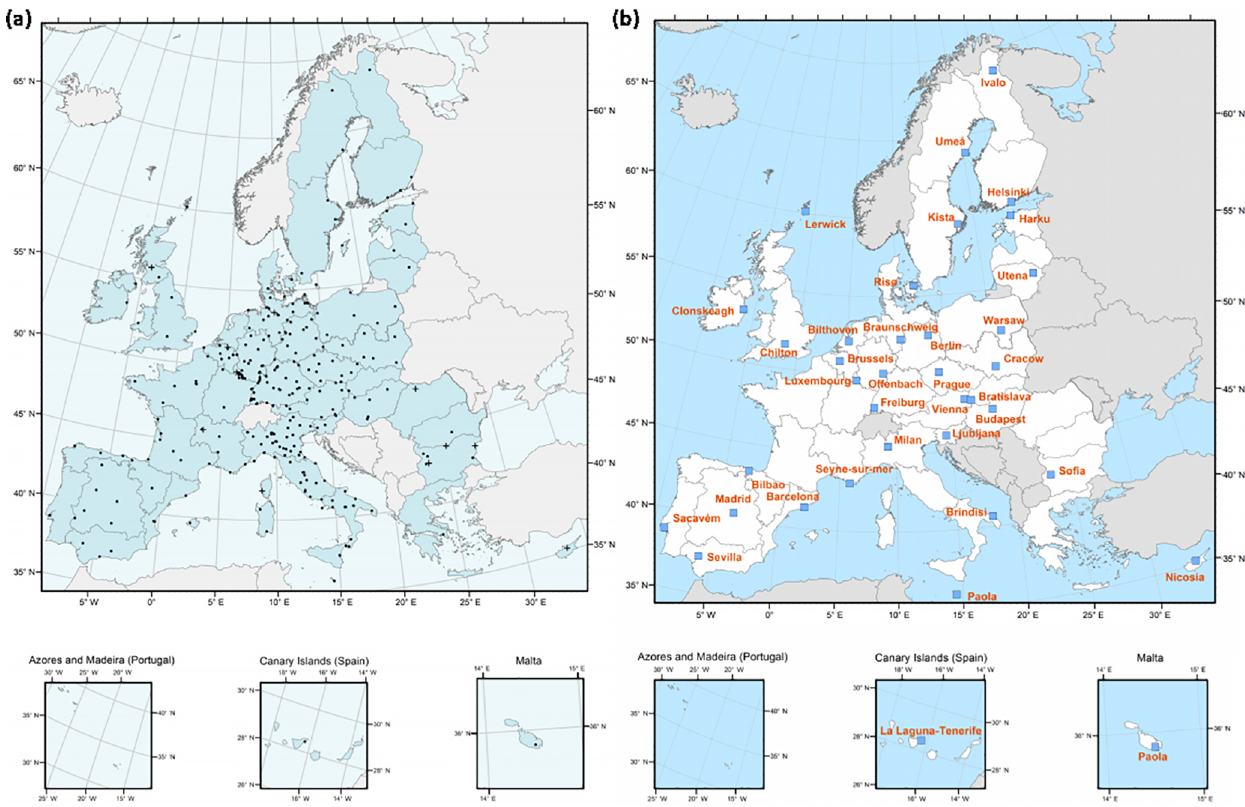
Figure 7. Example of sampling locations of dense (a) and sparse (b) networks for 137 Cs as airborne particulates, year